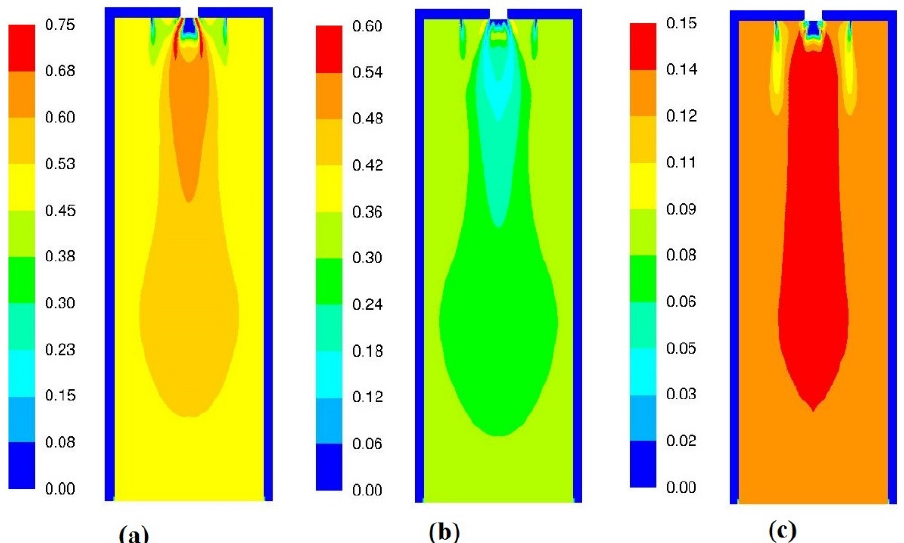
Figure 14. Species distribution in the plane passing through the centers of two powder feeding ports of design No. 5: ( a ) H 2 , ( b ) H 2 O, and ( c ) CO.